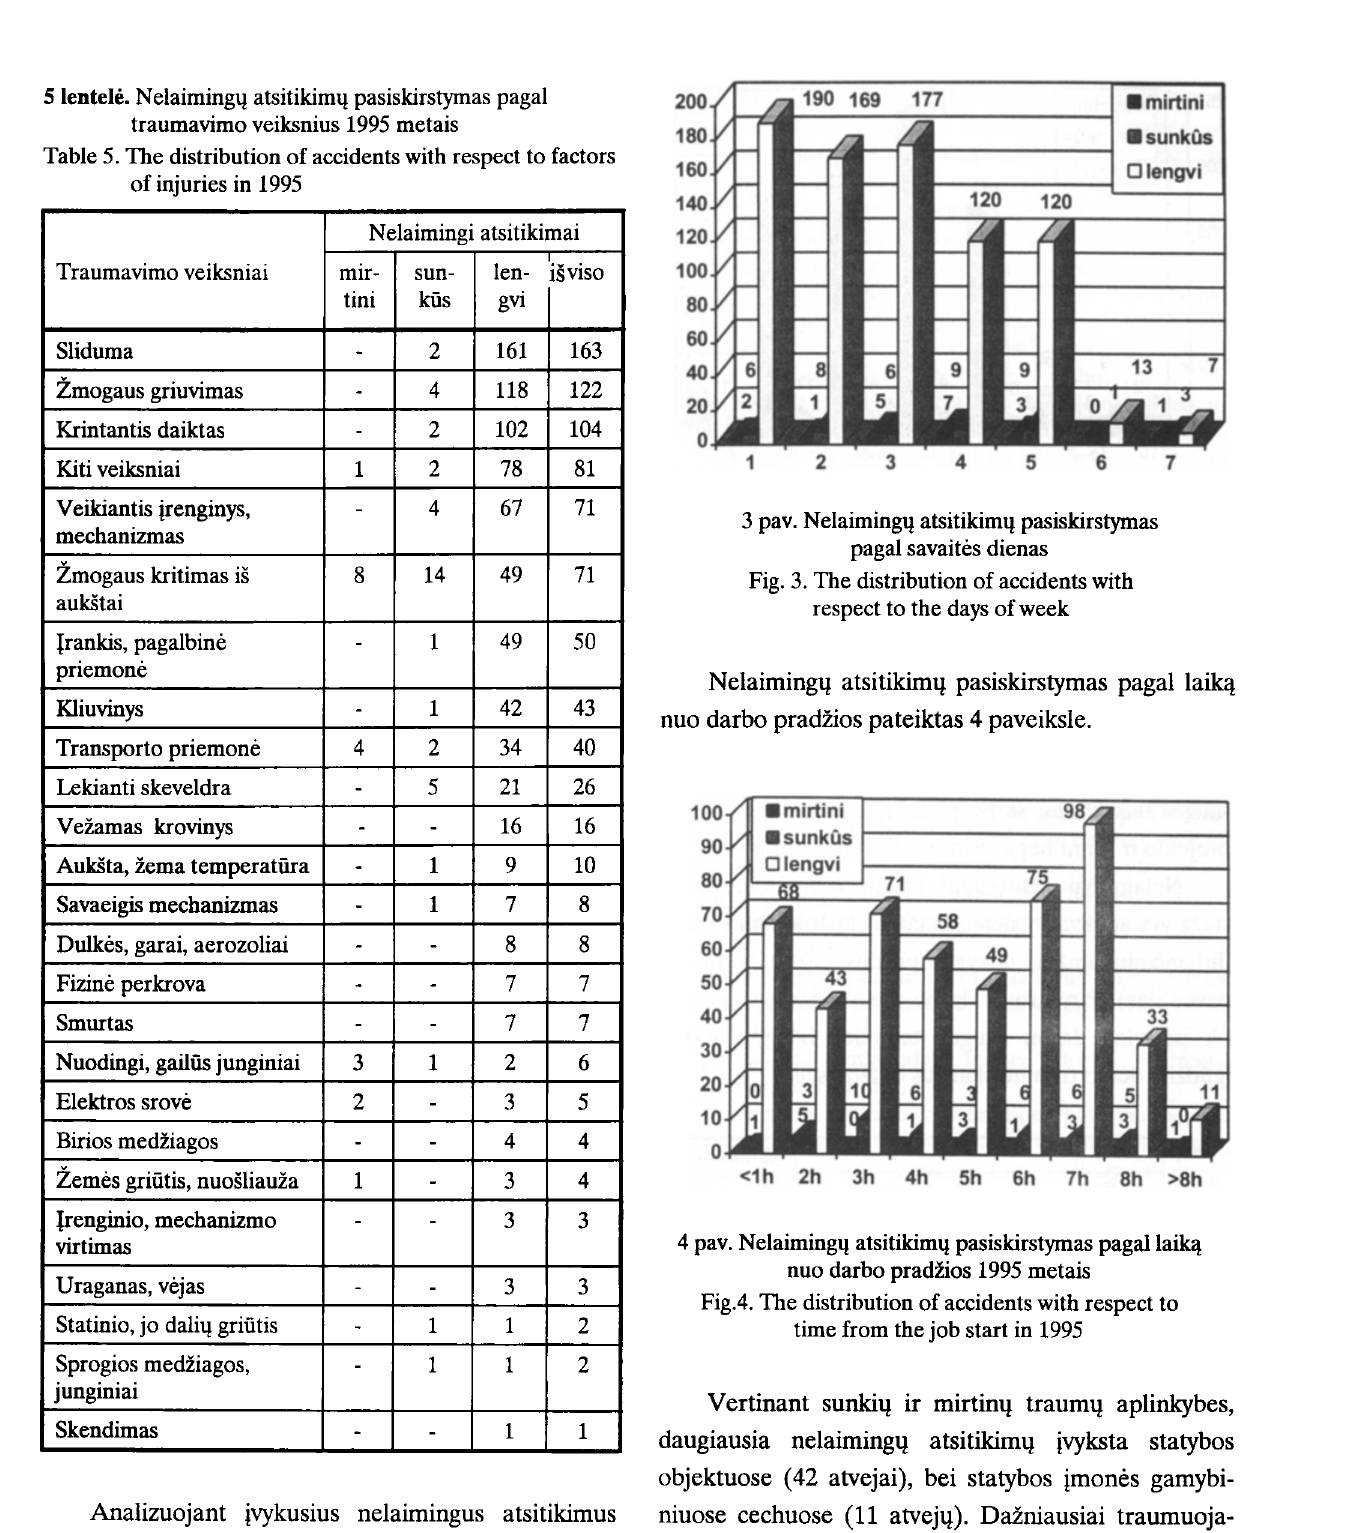
nuo darbo pradzios 1995 metais Fig.4. The distribution of accidents with respect to time from the job start in 1995 Vertinant sunkiq ir mirtinq traumq aplinkybes, daugiausia nelaimingq atsitikimq ivyksta statybos objektuose ( 42 atvejai), bei statybos imones gamybi niuose cechuose (11 atvejq). Dafniausiai traumuoja mi asmenys, dirbantys su veikianciais irenginiais. Sunkiq ir mirtinq traumq metu daugeliu atvejq traumuojamos tokios zmogaus kiino dalys: kojos - 10, galva - 9, rankos - 4, stuburas - 3, akys - 3 atvejai. Nelaimingq atsitikimq pasiskirstymas pagal